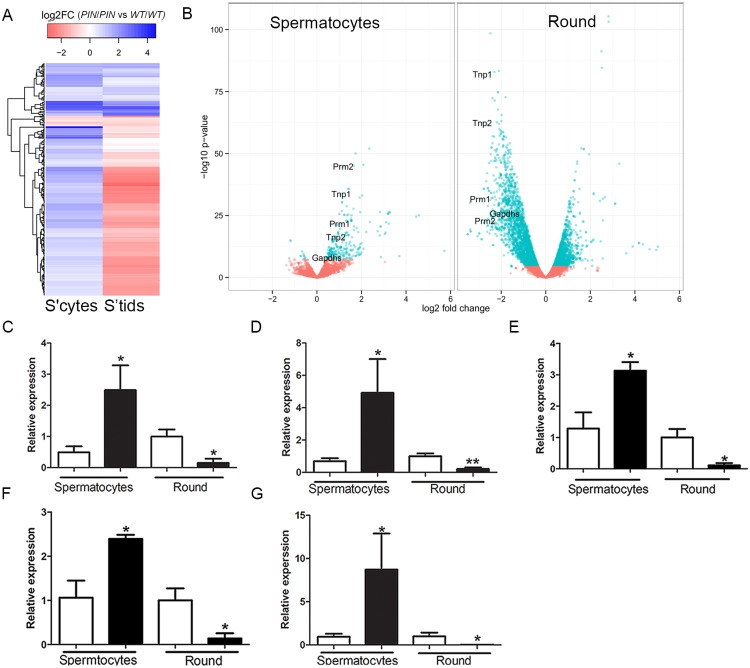
Altered gene expression in Henmt1
PIN/PIN spermatocytes and round spermatids.
(A) A heatmap showing log2 fold change in differentially expressed genes in spermatocytes and their corresponding log2 fold change in round spermatids (round). Color coding represent log2 fold changes of genes. Prm1, Tnp1, Tnp2, Prm2 indicate the position of transcripts subjected to further analysis. (B) A volcano plot showing expression changes of all detected genes in spermatocytes and round spermatids. Dots in cyan represent significantly differential expressed genes (FDR < 0.05) based on edgeR. Fold changes and p-values were calculated with edgeR. (C-G) qPCR of spermiogenic genes including (C) Tnp1 (D) Tnp2 (E) Prm1 (F) Prm2 (G) Gapdhs in 28 day-old Henmt1
WT/WT and Henmt1
PIN/PIN spermatocytes and round spermatids (n = 5 / genotype +/- SEM, * p<0.05, **p<0.01). White bar represents Henmt1
WT/WT and black bar is Henmt1
PIN/PIN. S’cytes = spermatocytes, S’tids = round spermatids. A two-tailed unpaired student T-test was performed for statistical analyses.